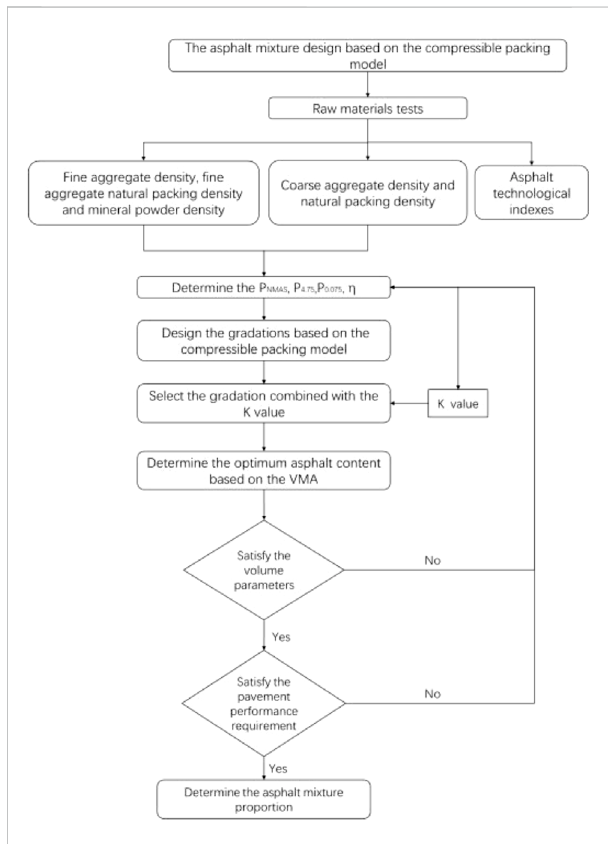
Figure 6 Veri fi cation of asphalt mixture design based on the compressible packing model.